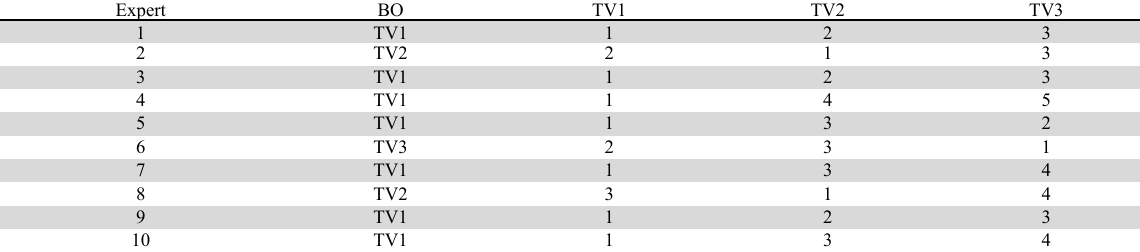
Transactional value preferences (Best to others) Expert BO